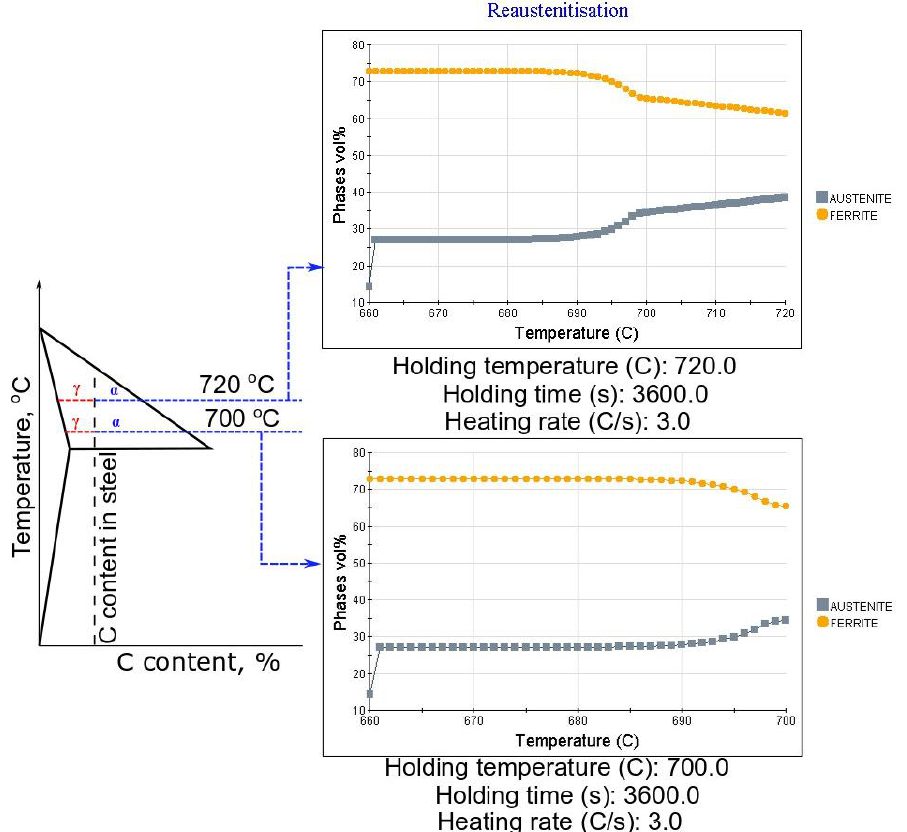
Figure 12. Schematic representation of a lever rule and theoretical calculations using JMatPro for intercritically annealed steels at 720 and 700 °C.